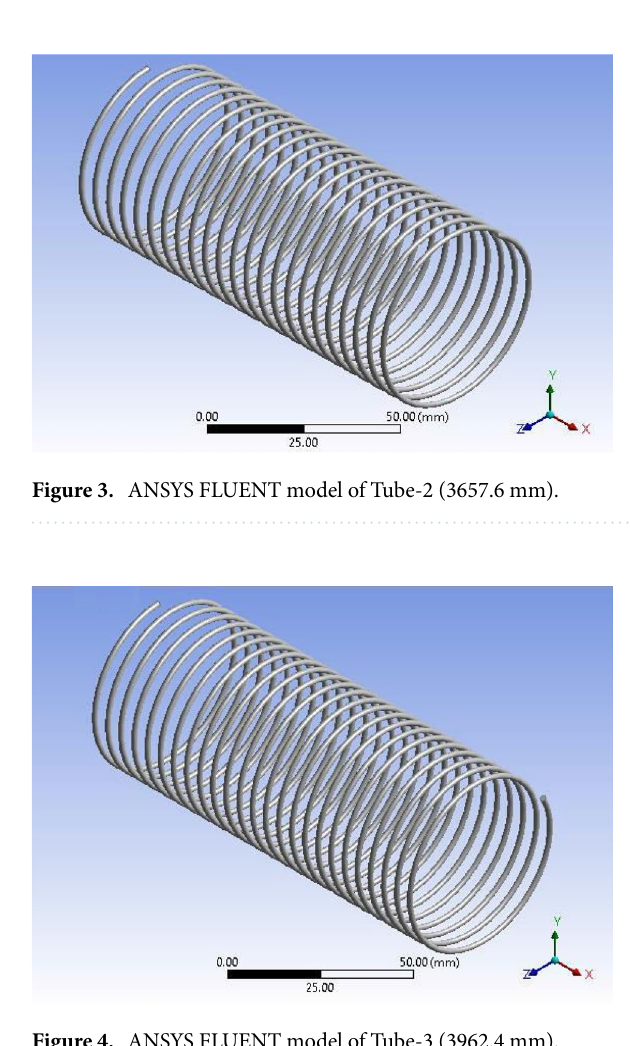
Figure 4. ANSYS FLUENT model of Tube-3 (3962.4 mm).